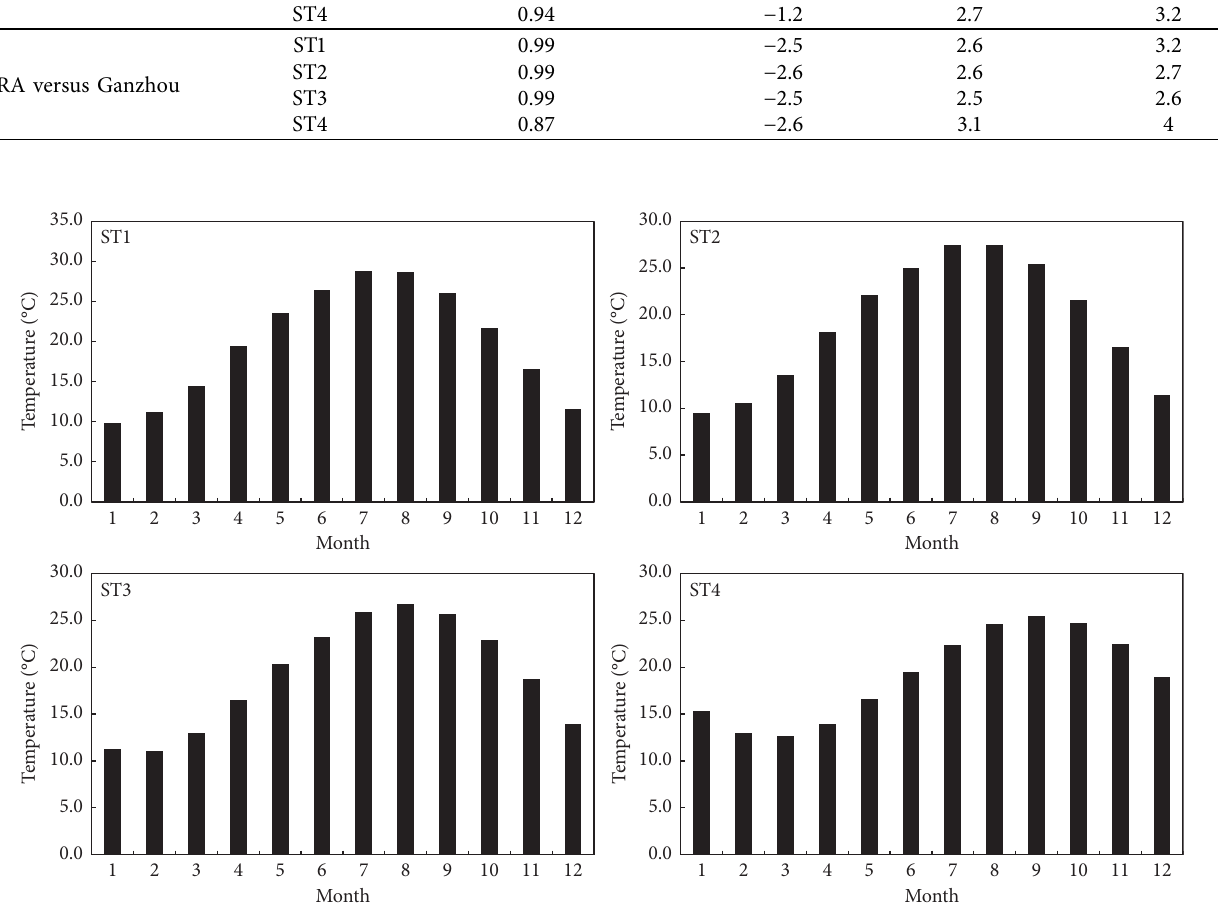
Figure 3: Monthly change of the soil temperature at the four soil depths.